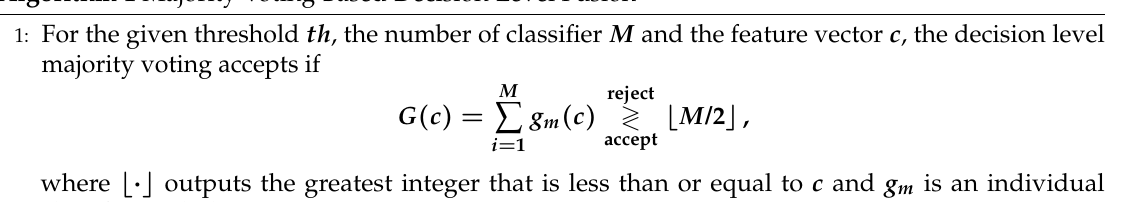
Algorithm 1 Majority Voting Based Decision Level Fusion